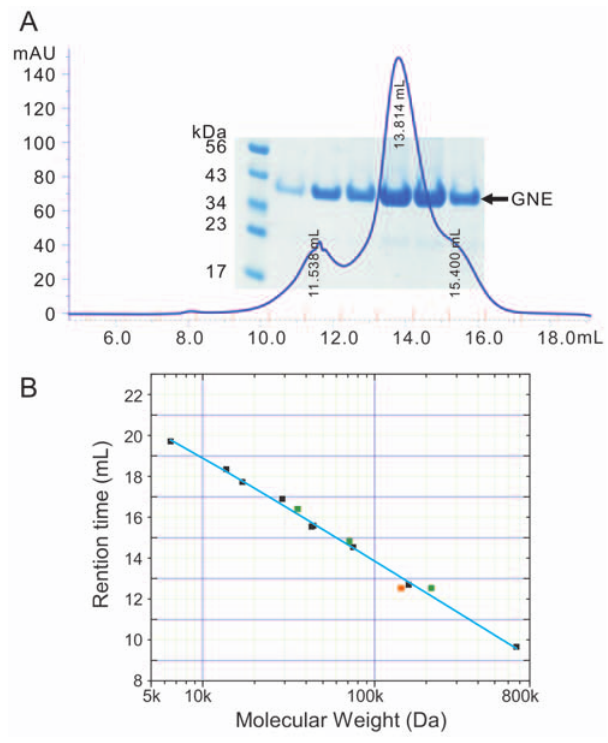
Figure 3. Oligomeric state analysis of the GNE kinase domain. Panel A: Superdex-200 10/300 (GE healthcare) size exclusion chroma- tography profile of GNE at 6 mg per mL concentration in 20 mM HEPES buffer, pH 7.5, 500 mM NaCl, 5 mM MgCl 2 , 1 mM tris-(2-carboxyethyl)- phosphine hydrochloride (TCEP). The lanes on the SDS-PAGE gel correspond to different fractions on the gel filtration profile. Panel B: Size exclusion column calibration curve and measurement of GNE kinase domain apparent molecular weight. Standard protein samples (black data points) used include thyroglobulin (670 kDa), globulin (158 kDa), conalbumin (75 kDa), ovalbumin (44 kDa), anhydrase (29 kDa), myoglobin (17 kDa), and ribonuclease (13.7 kDa). Green data points are values for GNE kinase domain in monomeric, dimeric and hexameric forms. The orange data point is for GNE kinase domain in putative tetrameric